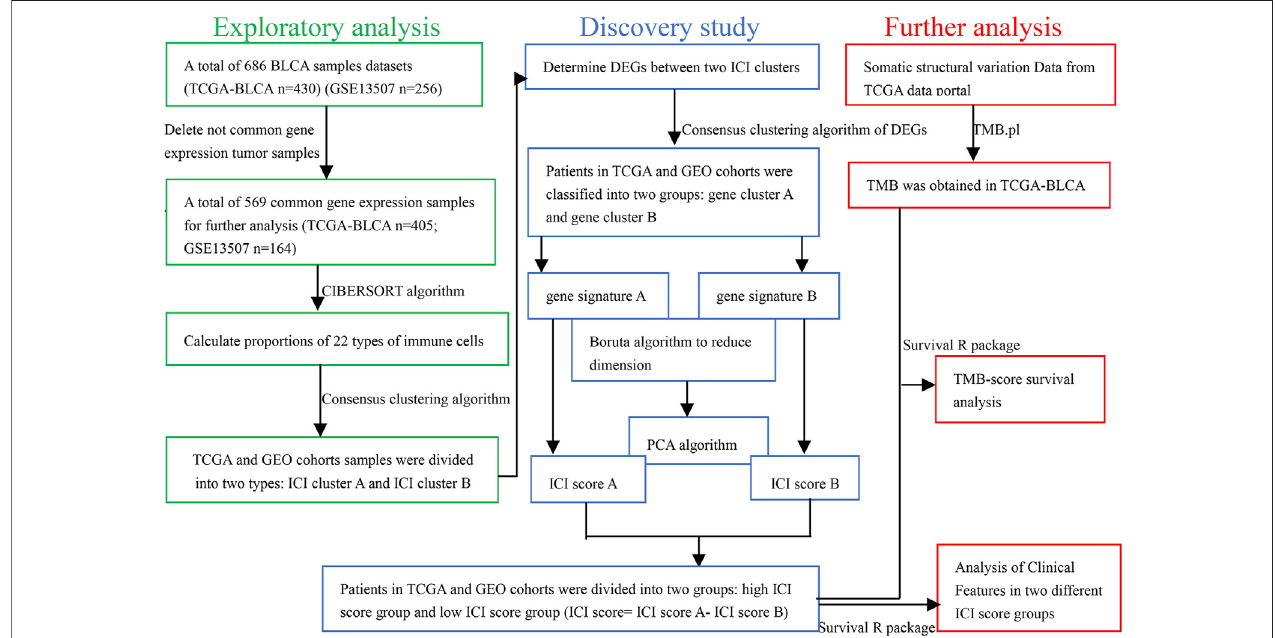
FIGURE 1 | Schematic diagram of research